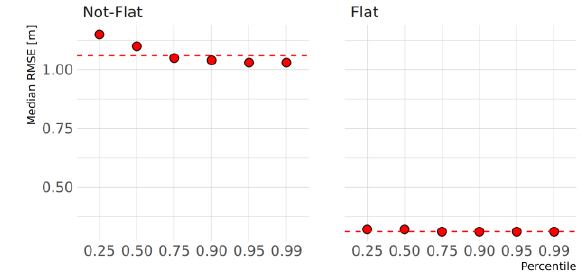
Figure 10. The median RMSE of the geometric difference between the point cloud and extruded 3D building models, analysed for both non-flat roofs (right) and flat roofs (left). The median per roof type is indicated with the red dashed line, which is 1.06 m for non-flat roofs and 0.31 m for flat roofs.